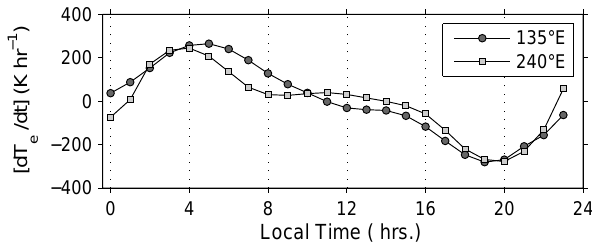
Fig. 10. LT variation of rate of change of T e corresponding to 135 ◦ E and 240 ◦ E, for 40 ◦ N latitude, from CHAMP